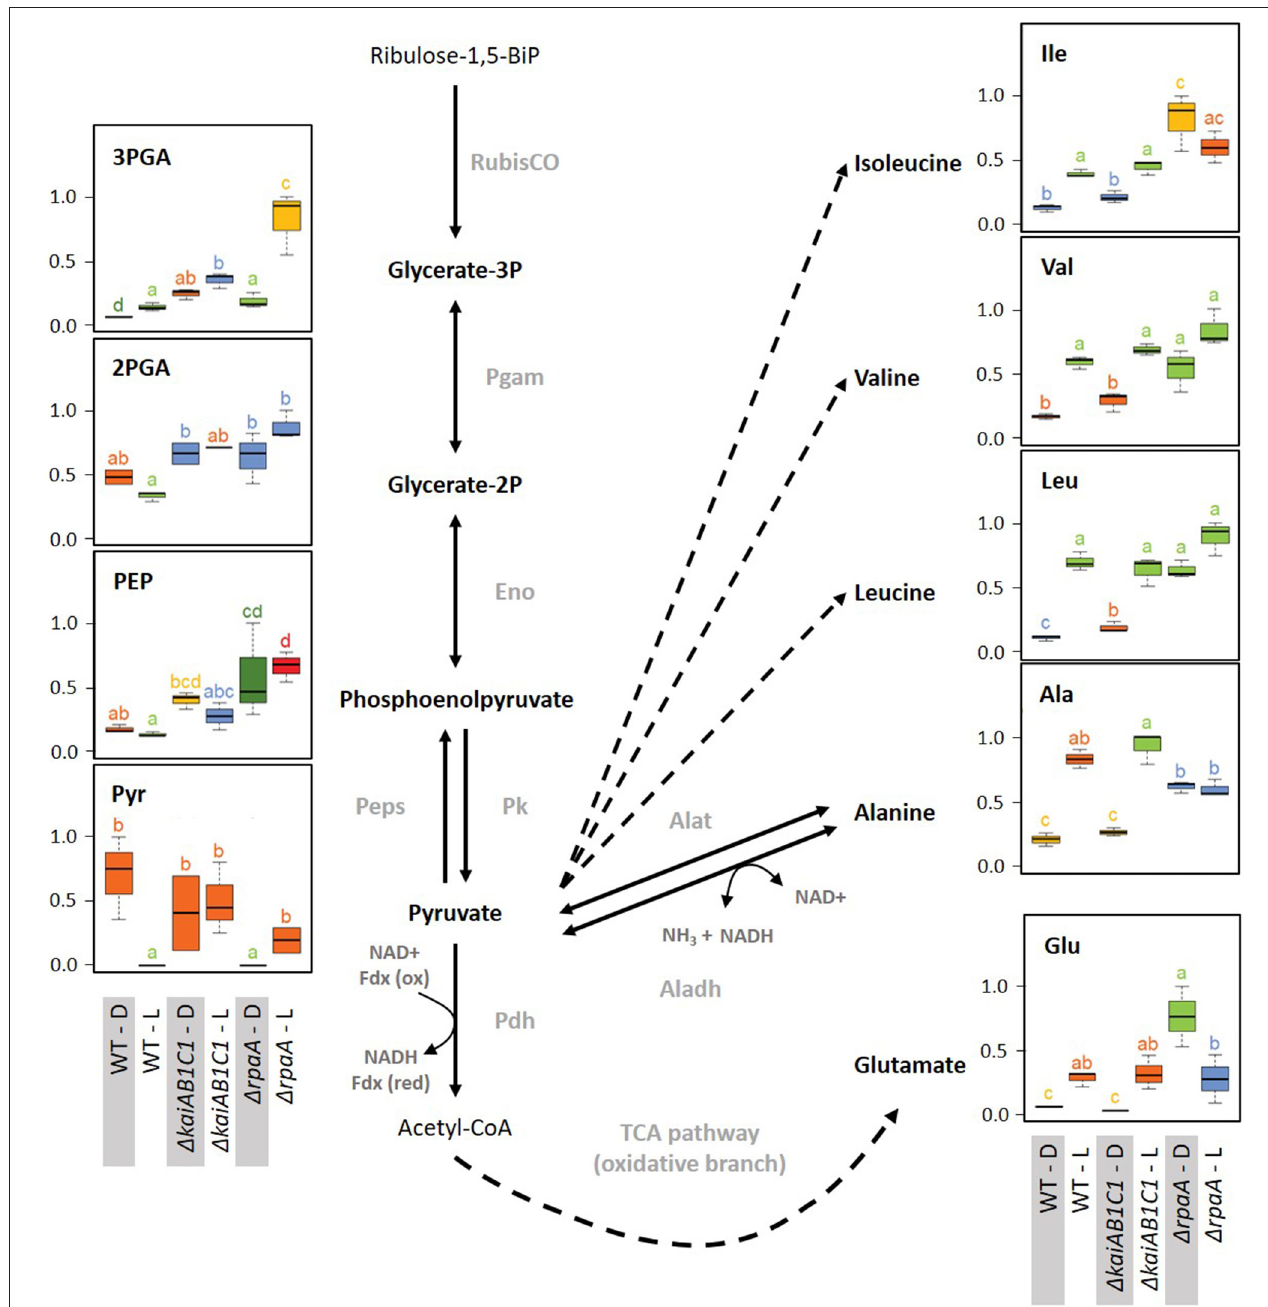
FIGURE 9 | Lower glycolysis, glutamate, and the pyruvate family of amino acids. Box plots showing the maximum normalized relative changes in the metabolite concentrations and Tukey test results ( P < 0.05, n = 3). Metabolite levels that significantly differ are indicated by lowercase letters and color coding. Note the subtle changes in the 1 kaiAB1C1 mutant, while the 1 rpaA mutant exhibited significantly increased pyruvate family amino acids, 3PGA, PEP, and glutamate in D. These changes are accompanied by pyruvate depletion in the D phase relative to the wild type. In the L, 3PGA accumulates in the 1 kaiAB1C1 mutant relative to the wild type. In the 1 rpaA mutant, 3PGA accumulates to even higher levels, and the 2PGA and PEP increases become significant. Dashed arrows indicate multiple reaction steps. Relevant enzymes and complexes include (gray) ribulose-1,5-bisphosphate carboxylase-oxygenase (RubisCO), phosphoglycerate mutase (Pgam), enolase (Eno), phosphoenolpyruvate synthase (Peps), pyruvate kinase (Pk), pyruvate dehydrogenase (Pdh), alanine dehydrogenase (Aladh), and alanine transaminase (Alat). metabolism. The 1 rpaA mutant, however, differed in the L/D such as ATP and reduced ferredoxin. Similar to the TCA responses of glutamate but not of glutamine; specifically, the pathways, the deficiency of KaiAB1C1 proteins did not affect glutamate concentrations increased in D ( Figure 11 ). ammonium assimilation or the associated glutamate/aspartate